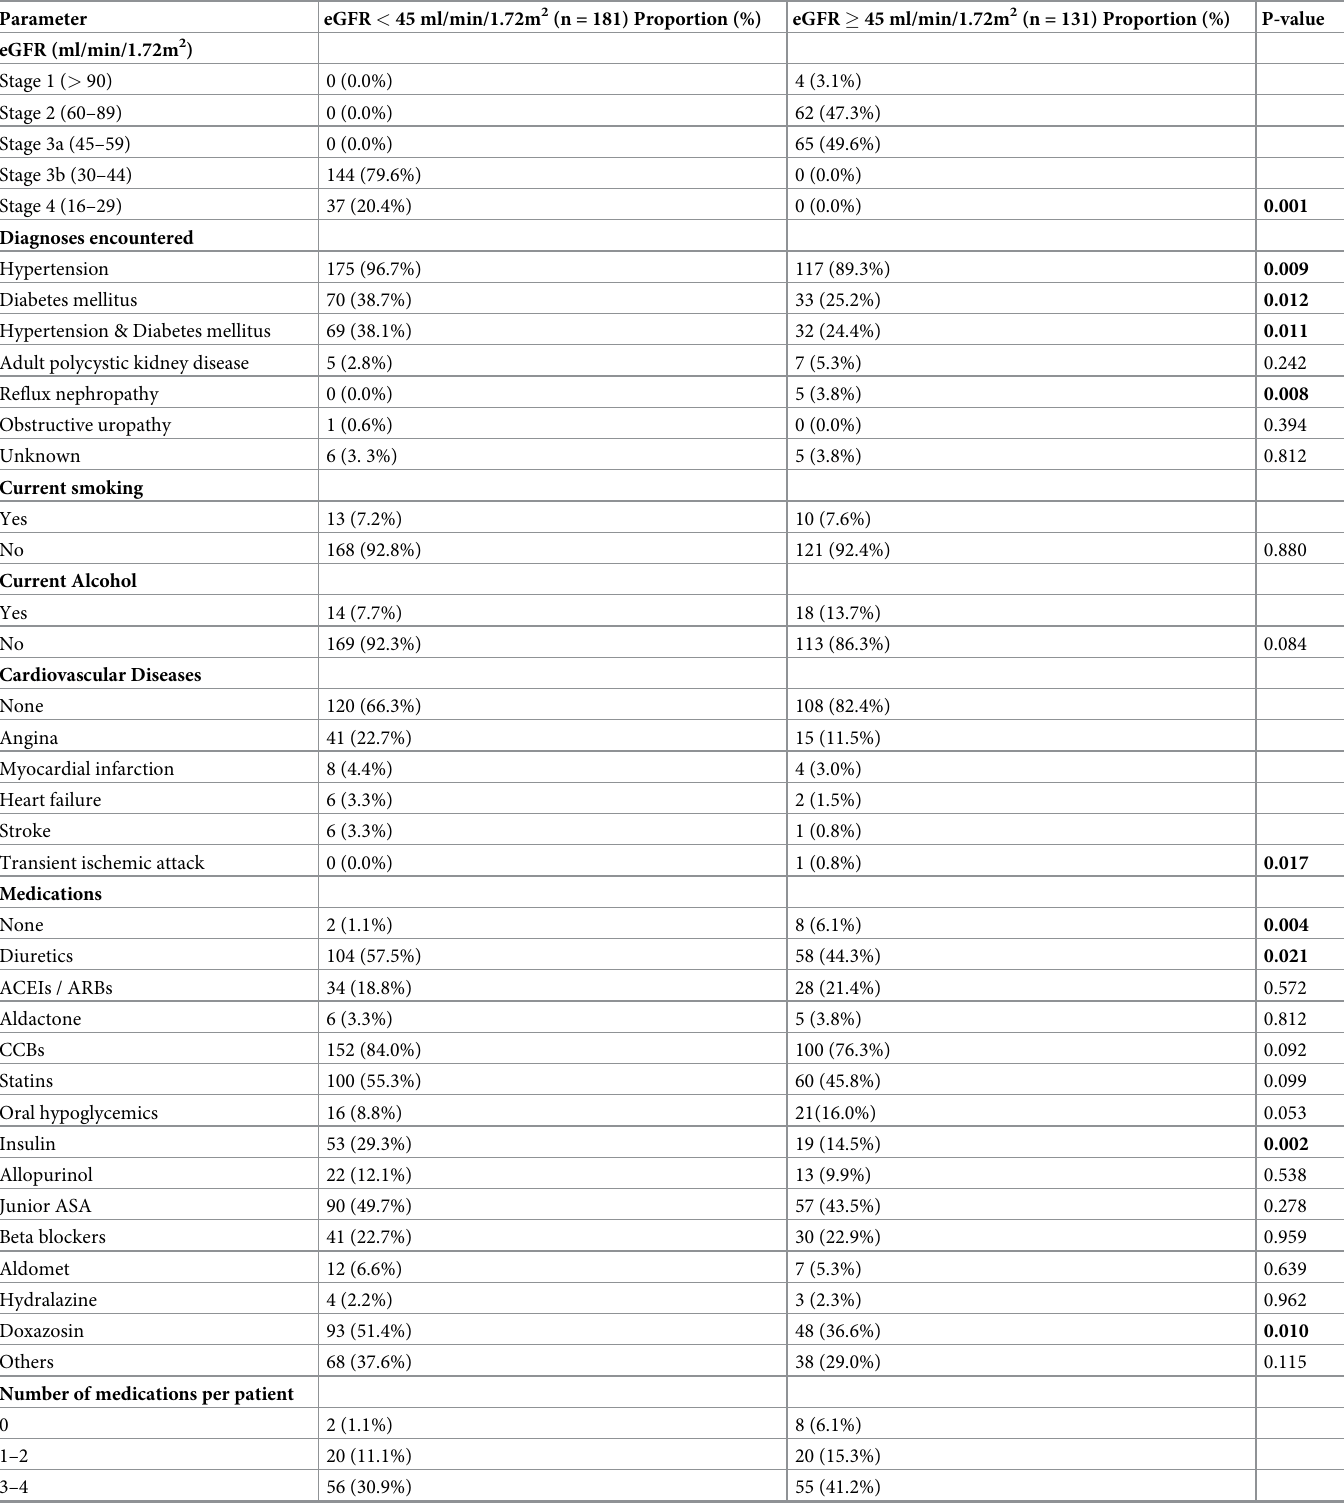
Table 2. Clinical profile of 312 CKD patients by eGFR.